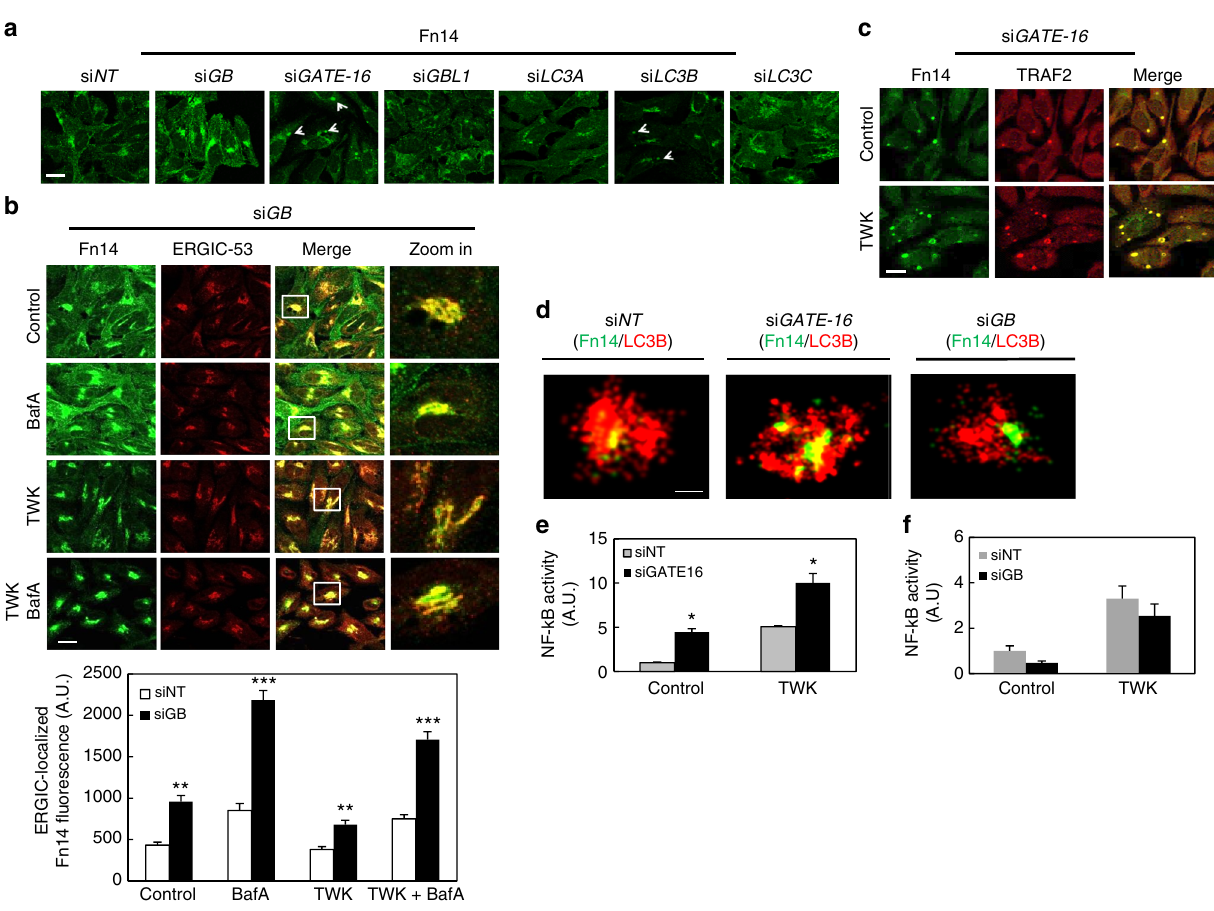
Fig. 6 Atg8 proteins differentially regulate Fn14. a HeLa cells were transfected with si NT or siRNA against individual Atg8 isoforms as indicated, immunostained for Fn14, and analyzed by confocal microscopy (scale bar, 20 µ m). b HeLa cells transfected with siRNA against GABARAP (si GB ) were treated with TWK and BafA as indicated, immunostained for Fn14 and ERGIC-53, and analyzed by confocal microscopy (scale bar, 20 µ m) (upper panel). Large magni fi cation of stained cells is presented in the right column. ERGIC-localized Fn14 fl uorescence was quanti fi ed from at least 10 fi elds (lower panel) (** P < 0.0025; *** P < 0.0001, comparisons by ANOVA. si NT — control, n = 9 cells; BafA, n = 14 cells; TWK, n = 19 cells; TWK baf, n = 22 cells. SiGB — control, n = 23 cells; BafA, n = 27 cells; TWK, n = 32 cells; TWK + BafA, n = 28 cells; mean ± s.e.m.). c HeLa cells transfected with siRNA against GATE-16 (si GATE-16 ) were treated with TWK as indicated, immunostained for Fn14 and TRAF2, and analyzed by confocal microscopy (scale bar, 20 µ m). d HeLa cells transfected with si NT , si GATE-16 , or si GB were immunostained for LC3B and Fn14, and analyzed by 3D STORM (scale bar, 300 nm). e , f Cells were transfected as with si NT or si GATE-16 ( e ) or si GB ( f ) and after 24 h were transfected with luciferase expression constructs as detailed under Methods, treated with TWK, and further subjected to luciferase assay as detailed to assess NF-kB activity (* P < 0.01, comparisons by T test; mean ± s.e.m.; n = 3 biological repeats and n = 2 biological repeats performed in triplicates,